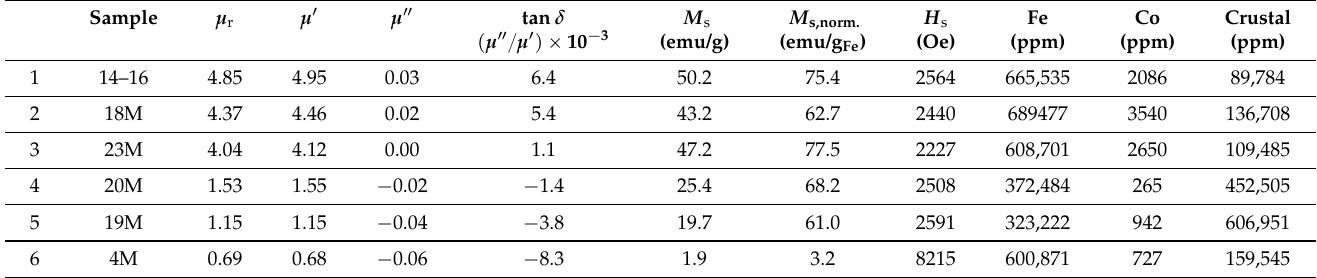
Table 1. Composition and magnetic properties of the ironsand samples used in this study. Sample location can be found in